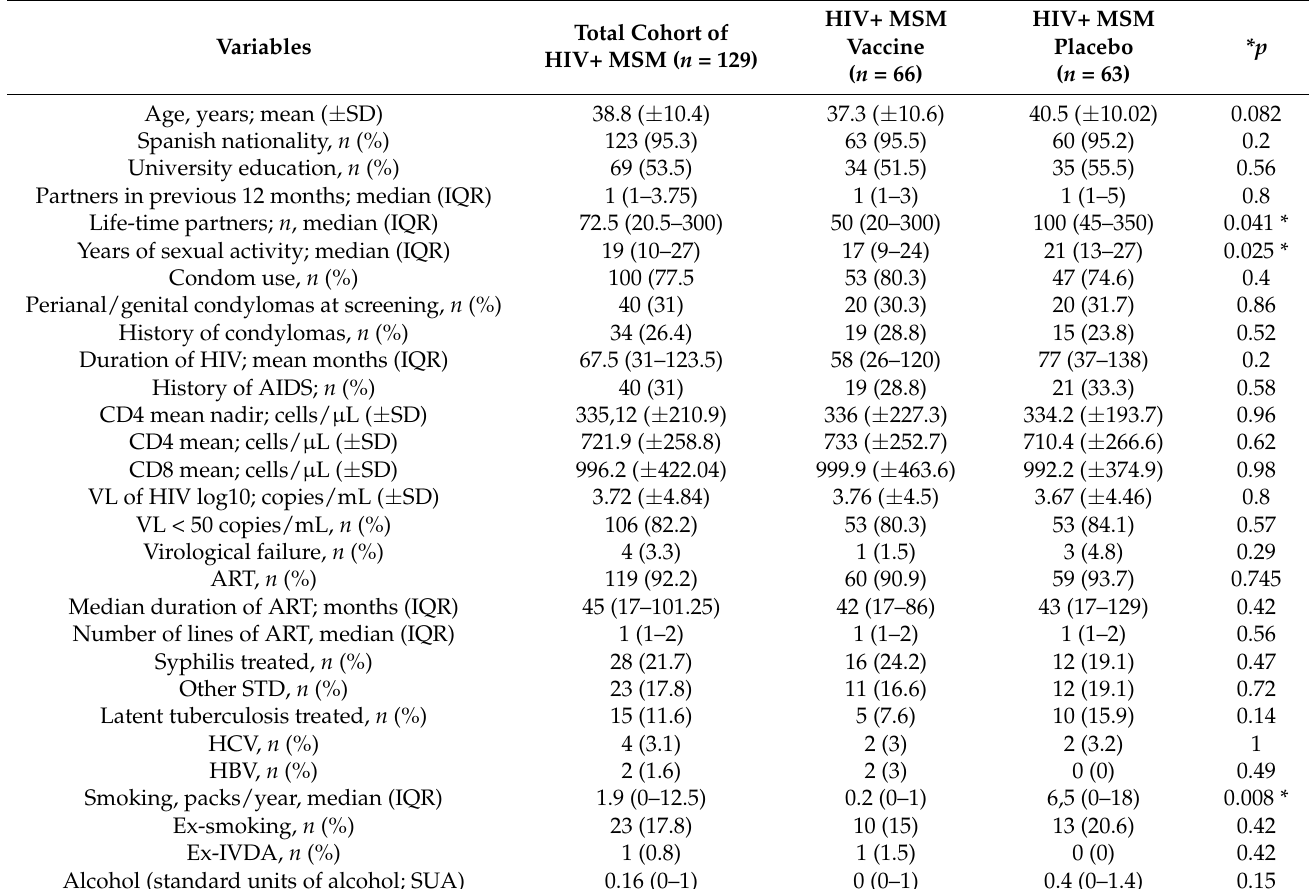
Table 1. Baseline demographics of HIV-positive men who have sex with men (MSM) enrolled in the clinical trial.